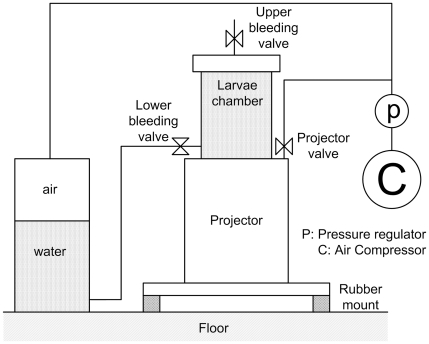
The ‘larvaebrator’ design.The larvaebrator is a device specifically designed to enable controlled exposure of fish larvae to sound in a laboratory setting.